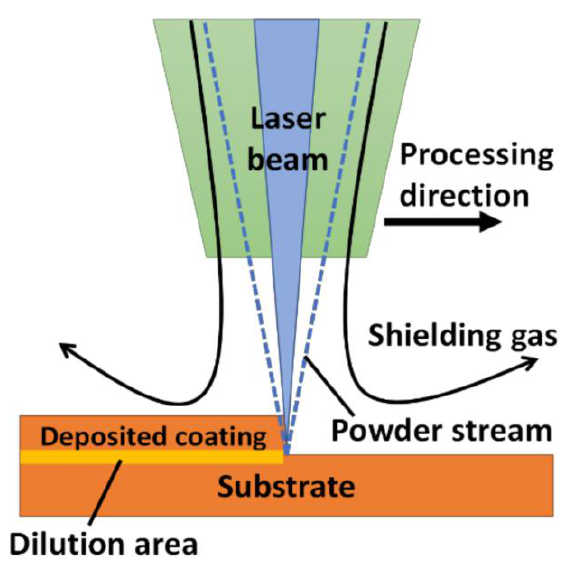
Figure 11. Schematic representation of the LBMD process [169].